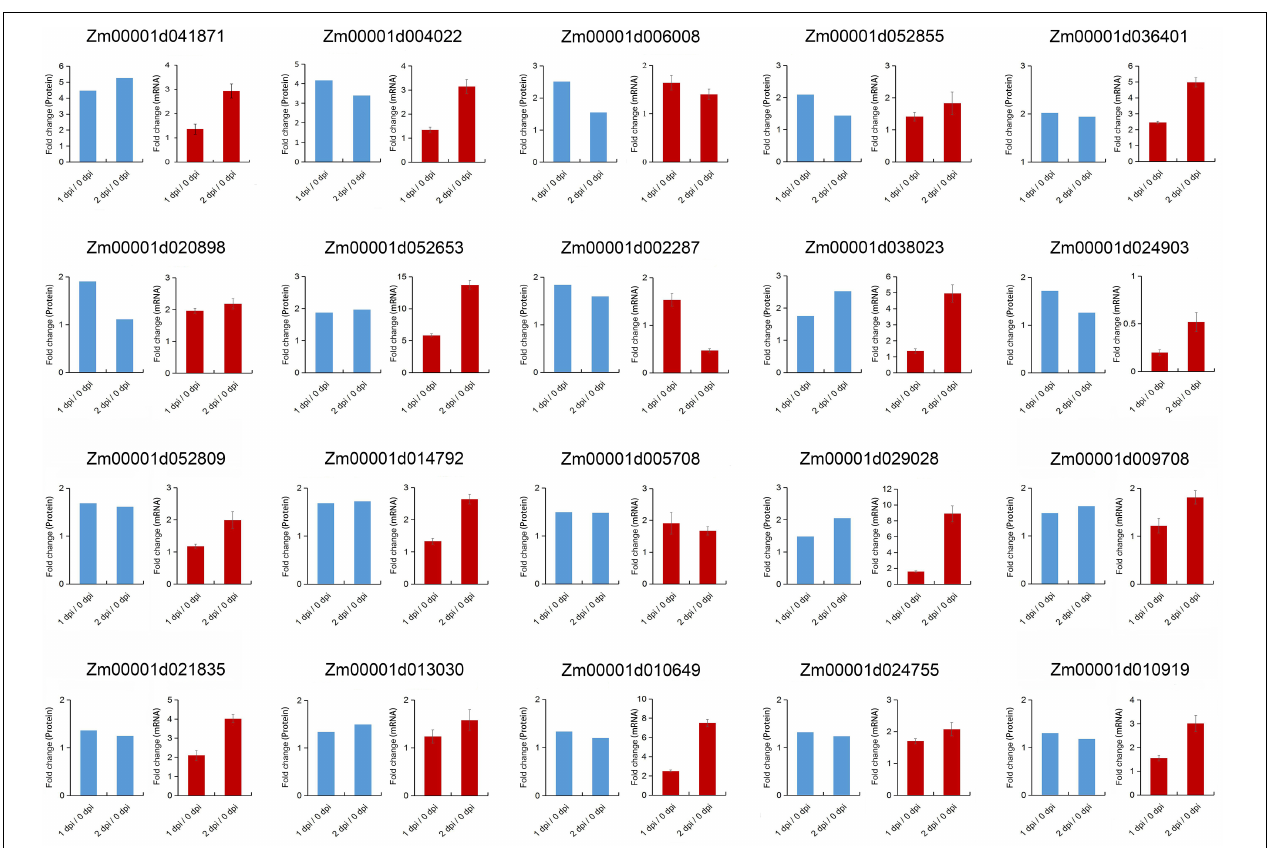
FIGURE 6 | Correlation between proteomics and quantitative real-time PCR (qRT-PCR) results of the proteins enriched in plant-pathogen interaction pathway. Error bars represent SD from the